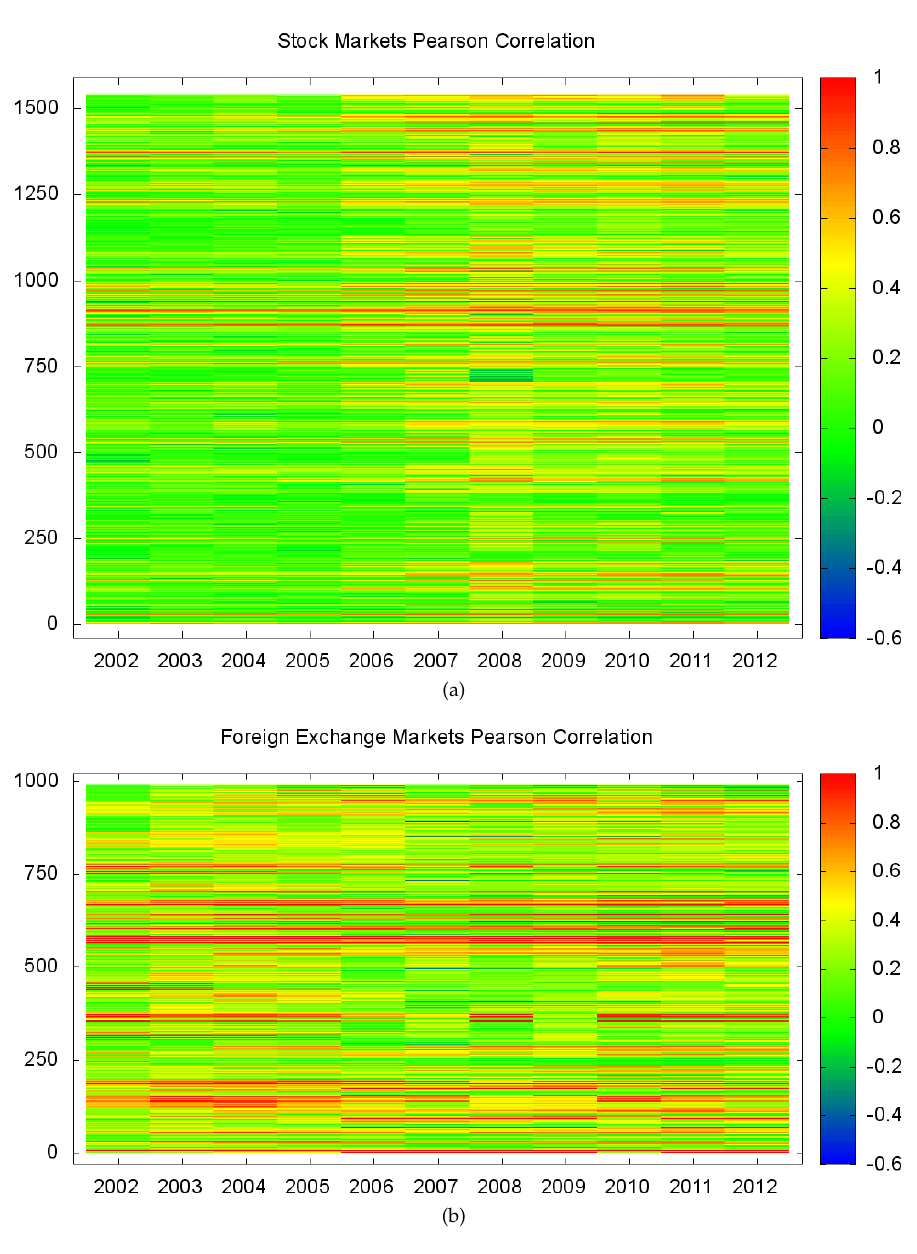
Figure 1. Heat maps of the annual Pearson correlations for ( a ) stock markets and ( b ) foreign exchange markets logarithmic returns. For the stock markets, we consider all 56 countries; for the foreign exchange markets, we consider the 45 distinct currencies. The color shows the value of the correlations for different years, where red indicates strong positive correlation, blue indicates strong negative correlation, while green means that the correlation is